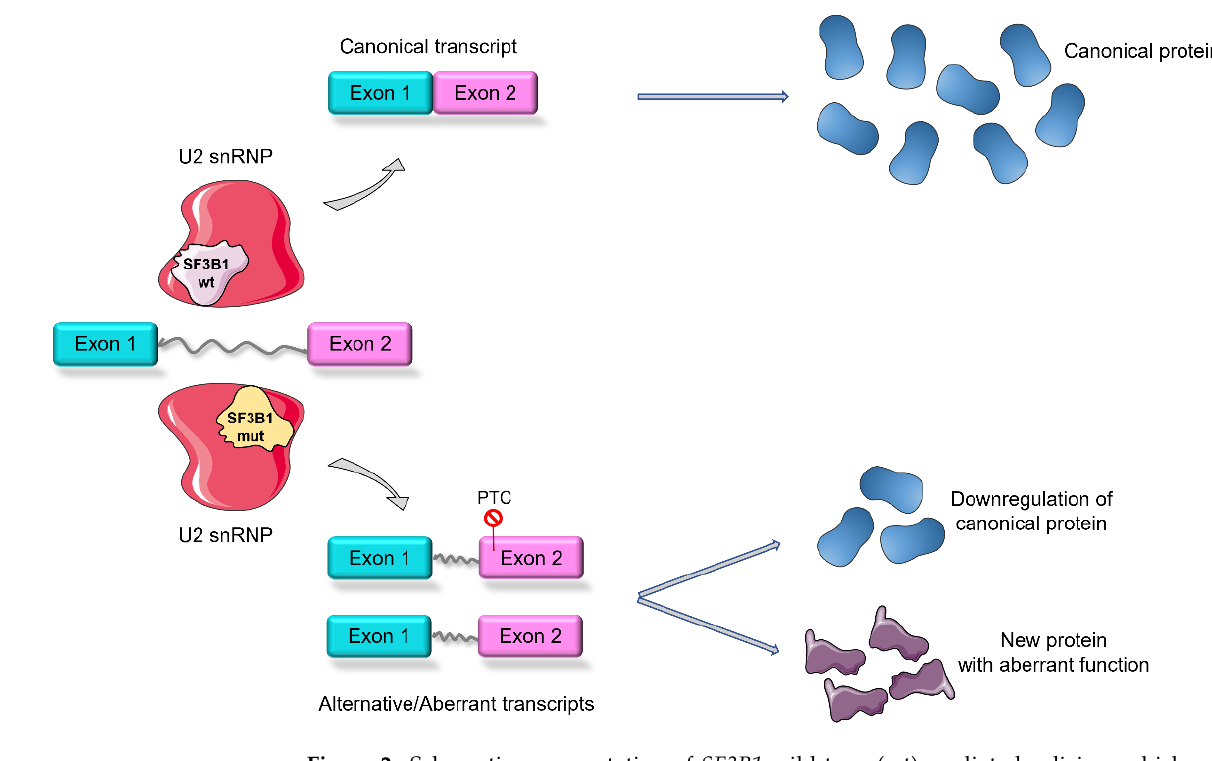
Figure 2. Schematic representation of SF3B1 wild-type (wt)-mediated splicing, which generates canonical transcription and translation, and SF3B1-mutated (mut)-mediated splicing, which results in aberrant/alternative transcription. As a consequence, premature stop codons (PTC) can form, leading to the down-expression of canonical proteins or the translation of new proteins with